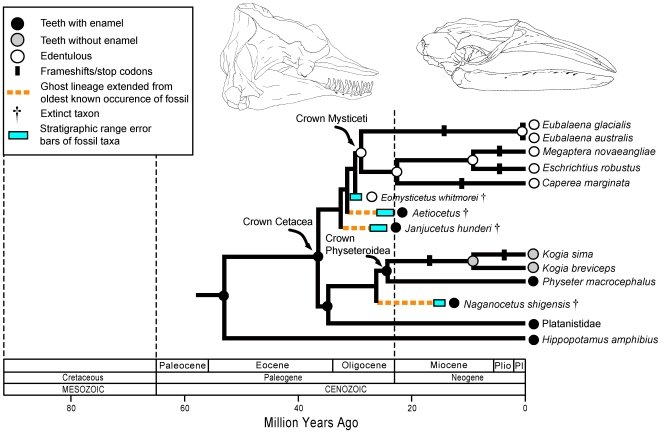
A synthetic interpretation of the history of enamel degeneration in Cetacea based on fossils, phylogenetics, molecular clocks, frameshift mutations, and dN/dS ratios.The common ancestor of Cetacea was reconstructed as having teeth with enamel based on the occurrence of teeth with enamel in stem cetaceans, stem mysticetes, and stem odontocetes. The common ancestor of Mysticeti was reconstructed as toothless based on (1) the fossil record, which records the transition from ancestral forms that possessed teeth but not baleen (e.g., Janjucetus), to intermediate forms with teeth and baleen (e.g., Aetiocetus), to forms that are fully edentulous (e.g., Eomysticetus) and (2) a dN/dS ratio for ENAM in crown mysticetes that agrees with the null hypothesis of neutral evolution (dN/dS = 1). The common ancestor of physeteroids was reconstructed as having teeth with enamel based on the presence of enamel-capped teeth in stem physeteroids (e.g., Naganocetus) and Physeter. Cladistic relationships and divergence times among extant taxa are based on McGowen et al.
[69]. Cladistic relationships of basal mysticetes and basal physeteroids are based on Deméré et al.
[15] and Bianucci and Landini [40], respectively. Frameshift mutations and stop codons were mapped using deltran optimization. All extant mysticete lineages that were sampled have at least one frameshift or stop codon, but none are shared by all mysticetes. Acctran optimization suggests that some homoplastic frameshifts and stop codons within Mysticeti may have resulted from lineage sorting of ancestral polymorphisms [15].